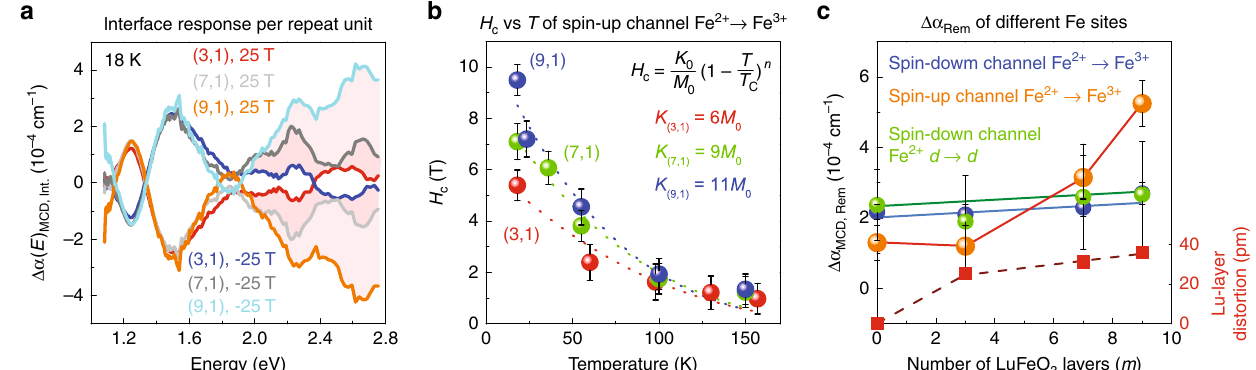
Fig. 3 Magnetic circular dichroism of the interfaces, coercive fi elds, and remnant magnetization. a Magnetic circular dichroism spectra of the interfaces on a “ per repeat unit ” basis. b Coercive fi elds obtained from analysis of the spin-up channel Fe 2 + → Fe 3 + charge-transfer excitation in the (3, 1), (7, 1), and (9, 1) superlattices vs. temperature. c Remanent magnetic circular dichroism for different types of Fe-related excitations and Lu-layer distortion vs. the number of LuFeO 3 layers ( m ). The Lu-layer distortion is taken from ref. 20 , where total displacement d = 1.5 × Q the distortion amplitude 44 . See Table 1